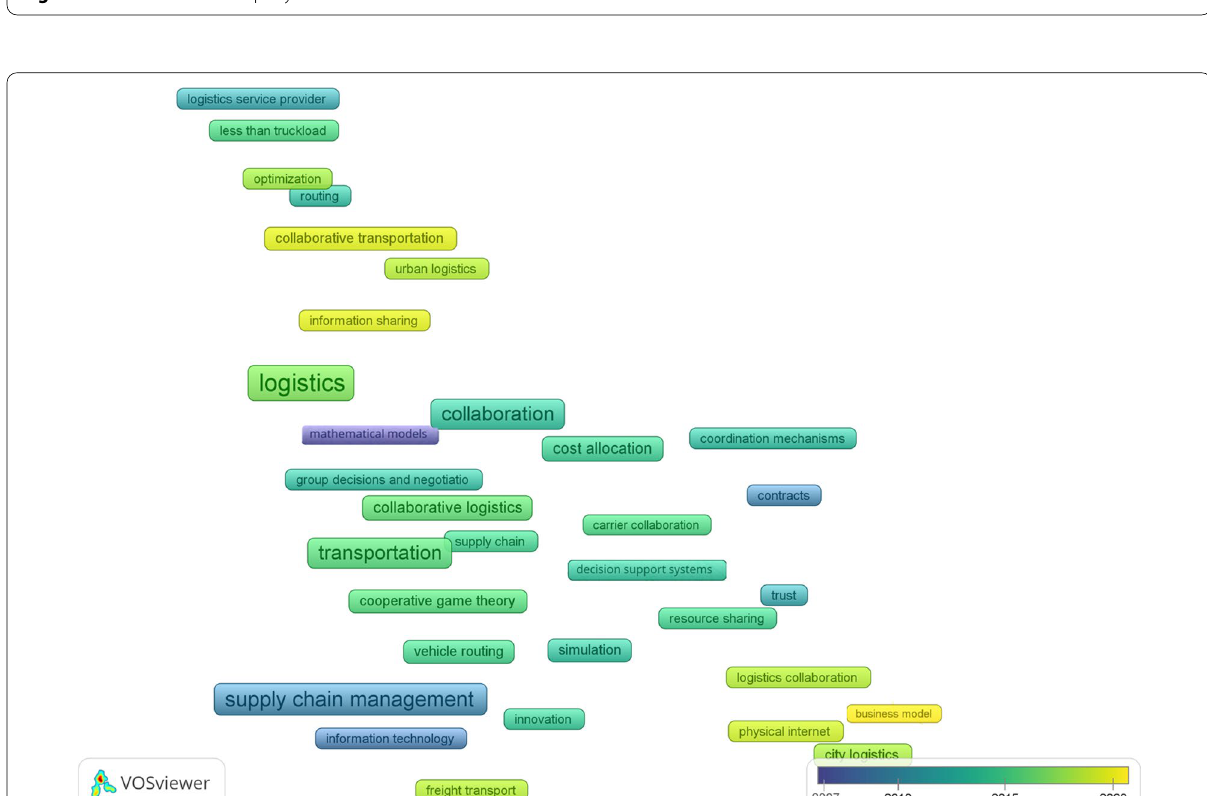
Fig. 3 Visualization of author keywords from 2007 to 2020 using